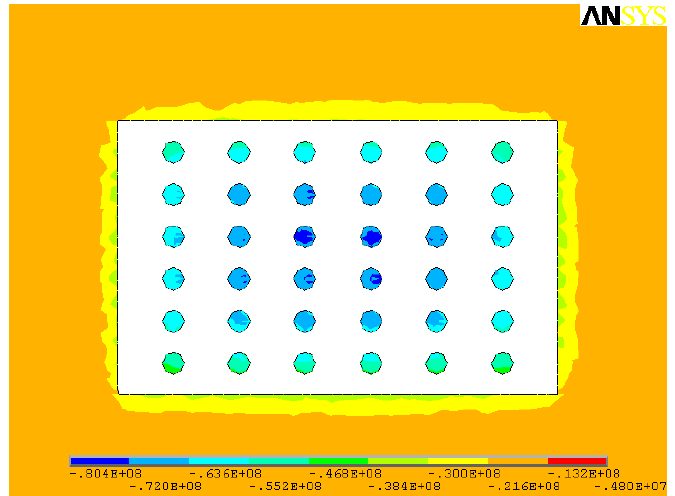
Figure 18. Minimum principal stress distribution in the middle of the pillar at 1480 mL of scheme 1 (parameters of scheme 1: stope height 2.5 m, pillar diameter 2 m, pillar spacing 4 m, pillar row spacing 6 m).